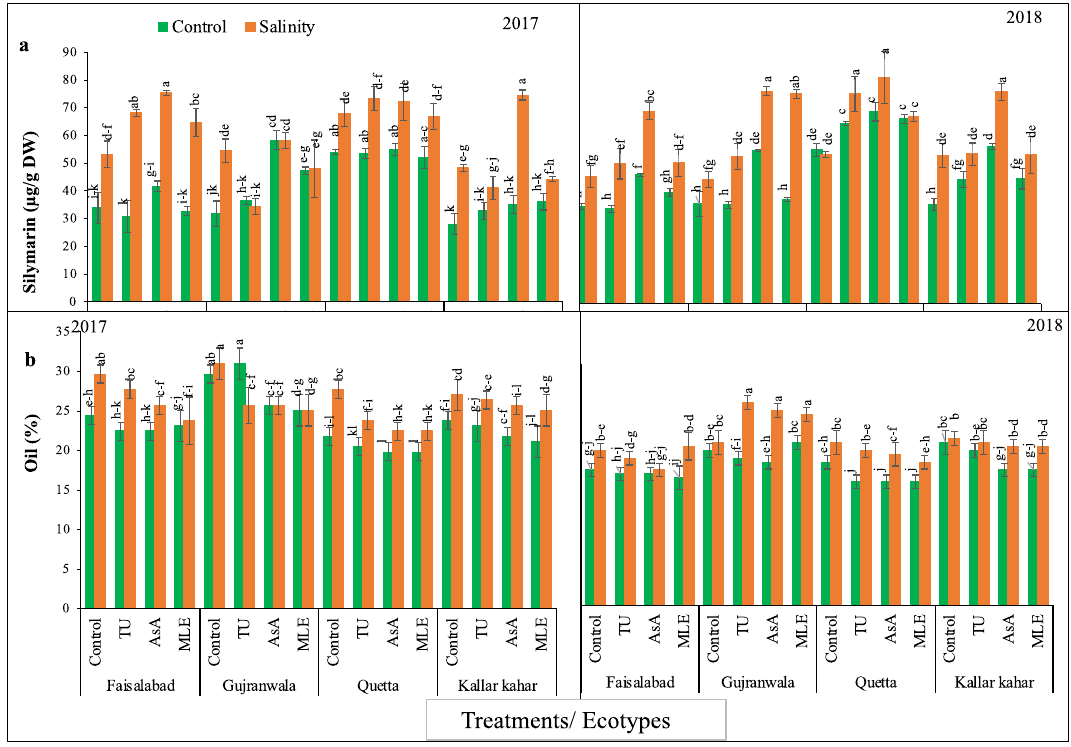
Figure 4. ( a ) Silymarin content, and ( b ) oil content achene of milk thistle under control and salinity stress conditions. The plants were soil supplemented with different plant growth promoters during 2017 and